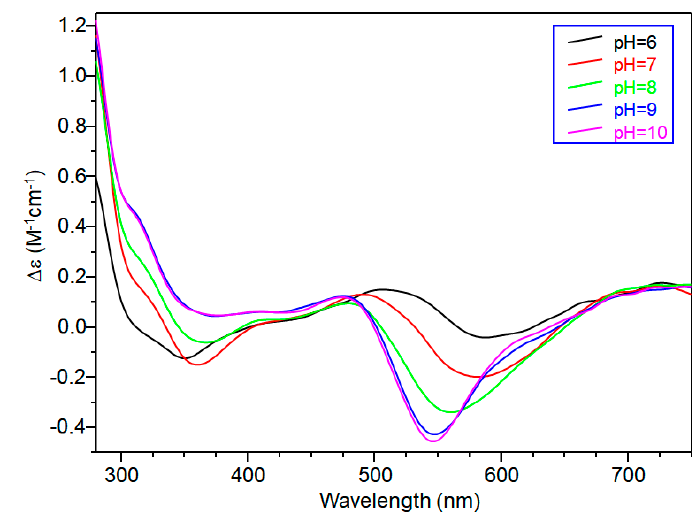
Figure 3. Circular dichroism (CD) spectra of Cu(II)-TrkA(58–64) at different pH values at 1:1 metal-to-ligand molar ratio (L = 1 × 10 − 3 mol·dm − 3 ).